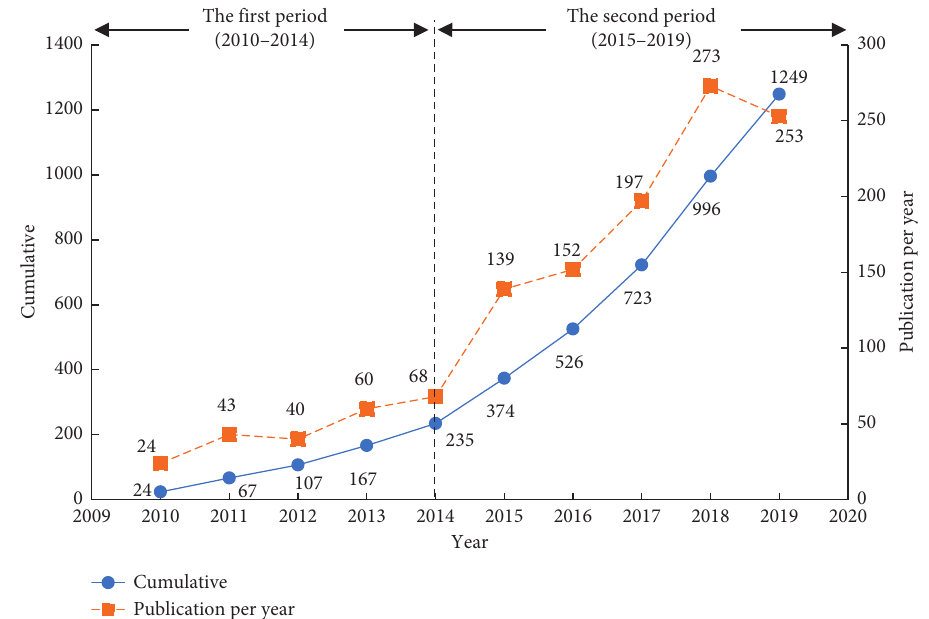
Figure 2: Distribution of annual publication outputs in the resilient city field from 2010 to